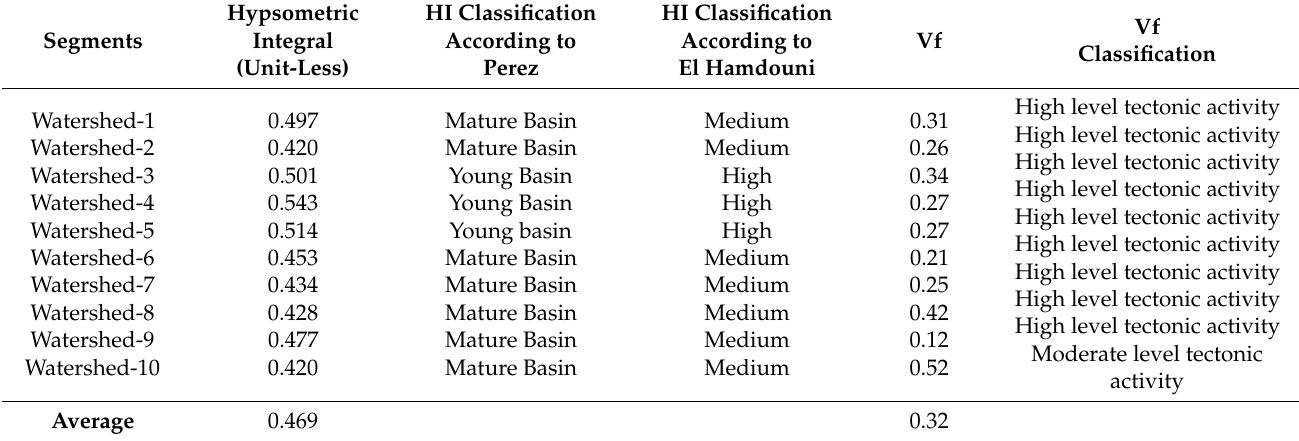
Figure 15. Hillshade map with stream order for Harnai Fault. The colored areas show the watersheds numbered from 1 to 14. The black line with star displays the location of the Vf index. Table 3. Hypsometric integral and VF values for Karahi